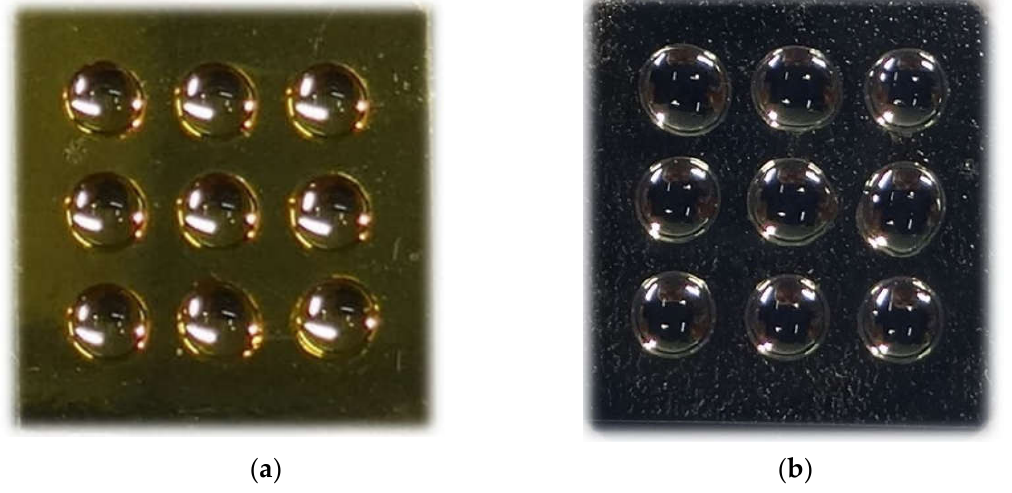
Figure 1. Photograph showing chip made from ( a ) pure gold; ( b ) Ag/Au covered with adhesive foil and nine measured samples.